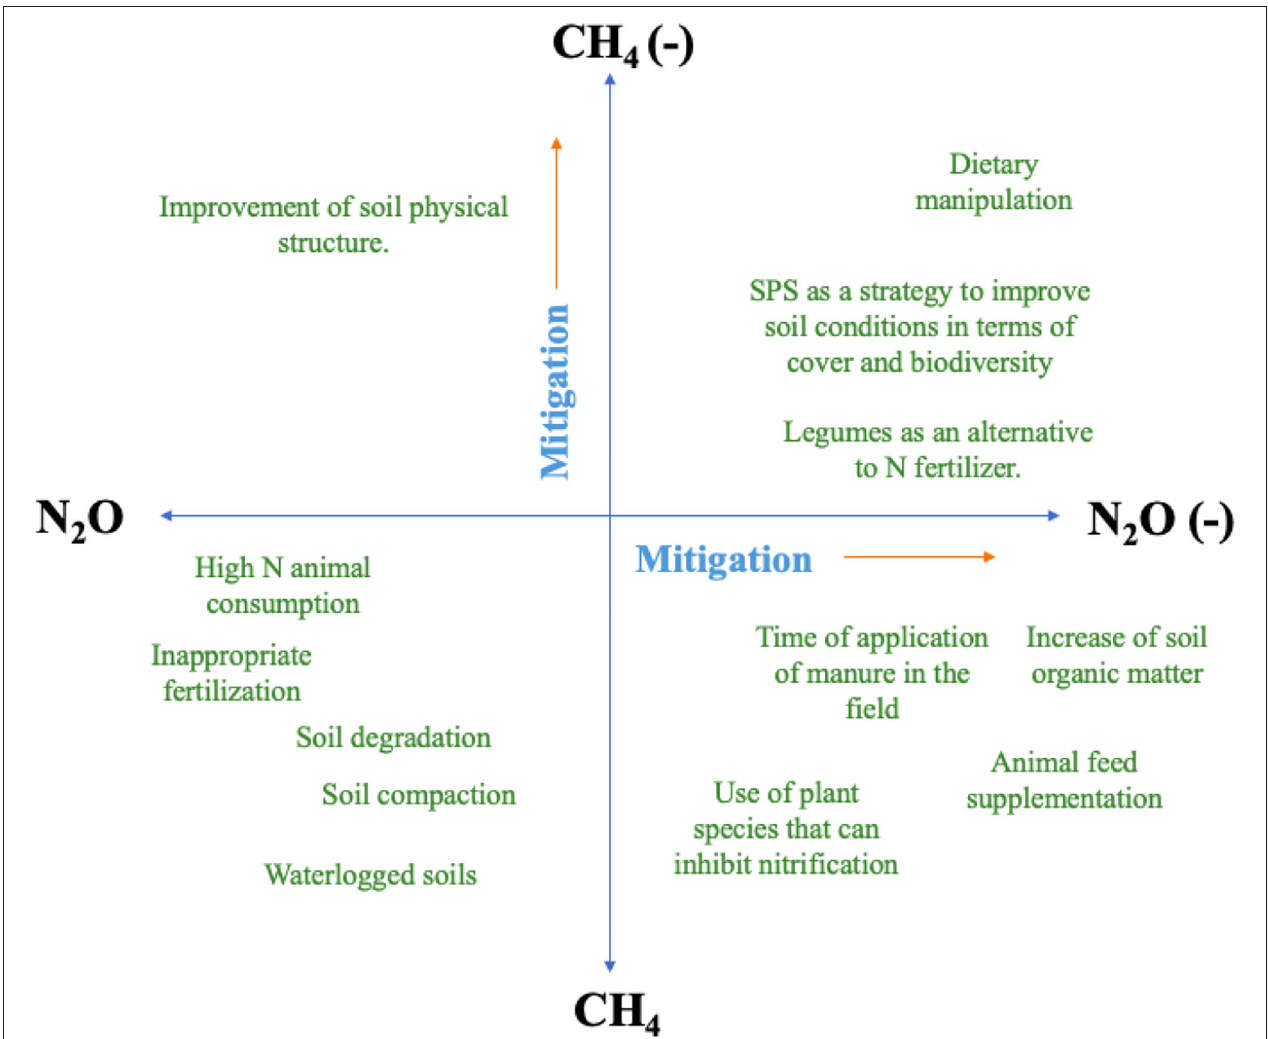
FIGURE 3 | Mitigation strategies classification, limitations and potential for reducing CH 4 and N 2 O emissions in grazing